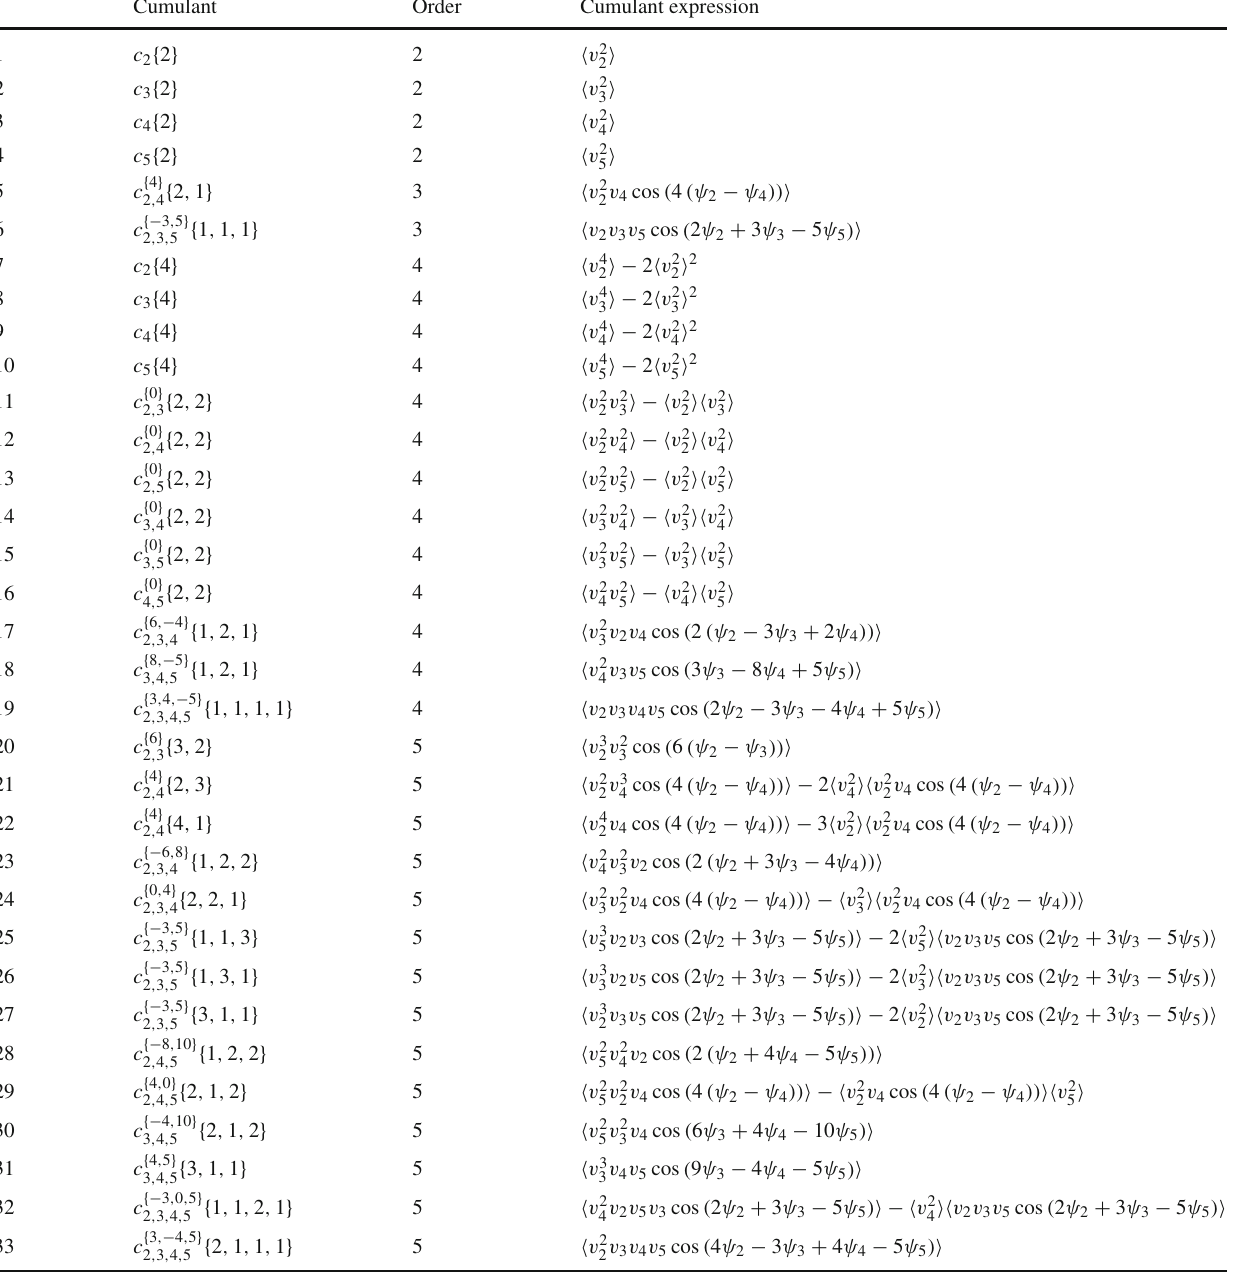
Table 1 List of all cumulants with order q = 2 , 3 , 4 , 5 and harmonics n = 2 , 3 , 4 , 5 Cumulant Order Cumulant